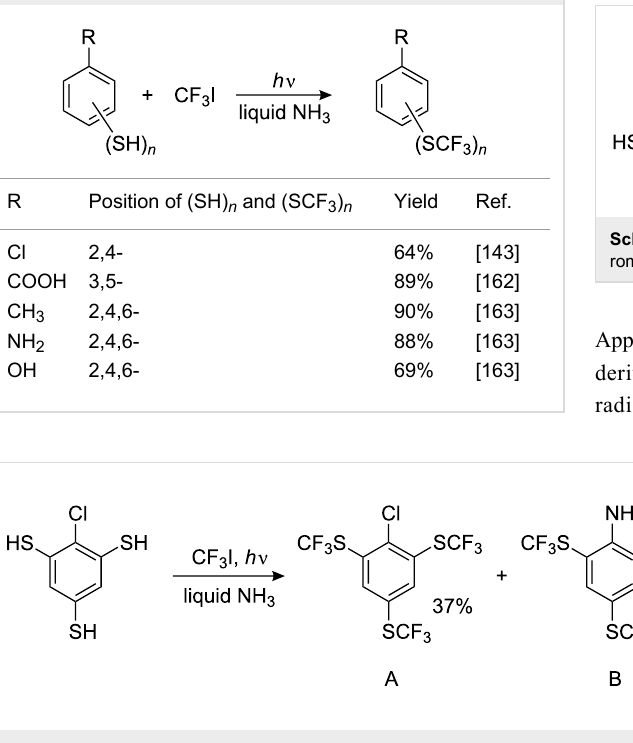
Table 2: UV irradiation of polymercapto benzenes with CF 3 I in liquid NH 3